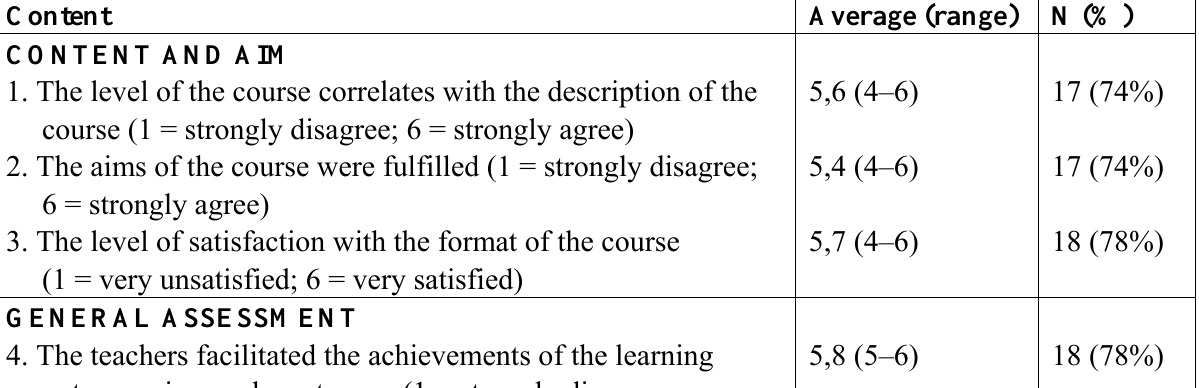
Table 4. Responses to Karolinska Institute’s evaluation questionnaire after the